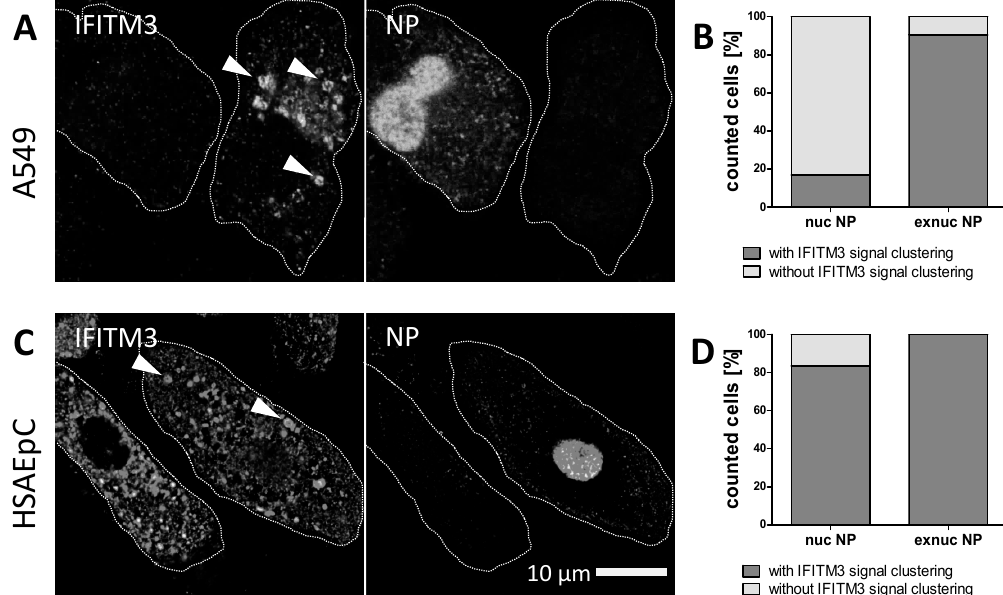
Figure 5. IFITM3 enriched regions in IAV infected cells. The indirect immunofluorescence of influenza A virus (IAV) A / Puerto Rico / 8 / 1934 (MOI = 1) infected ( A ) A549 cells and ( C ) HSAEpCs. The cells subjected for fluorescence microscopy were fixed at 10 h p.i. and stained using anti-IFITM3 and anti-NP antibodies. The periphery of the immunostained cells was outlined with white dot lines on the basis of the cell morphology. White arrow heads point at vesicular structures. The image acquisition was performed using a 60 nm ( = confocal mode) pixel size. ( B , D ) The analysis of the IFITM3 clustering with respect to the presence of nuclear (nuc) or extranuclear (exnuc) NP signals, respectively.